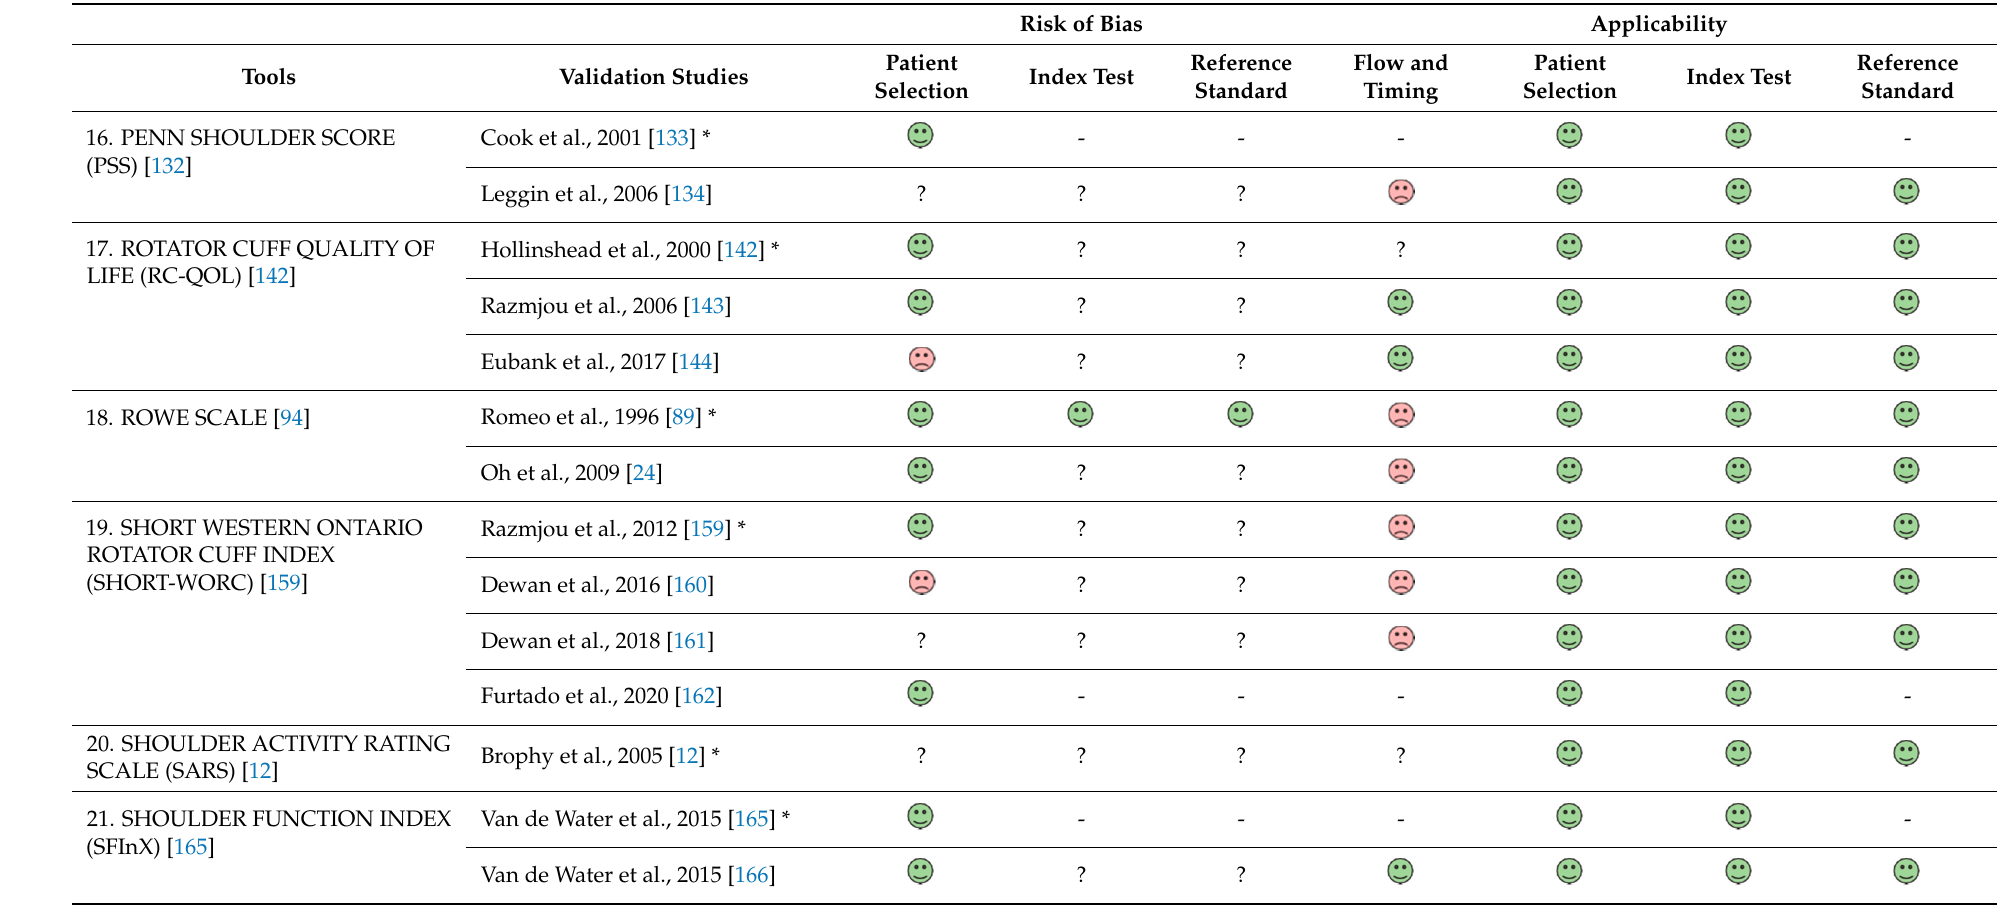
Table 3. Assessment of the methodological quality with QUADAS ‐ 2.